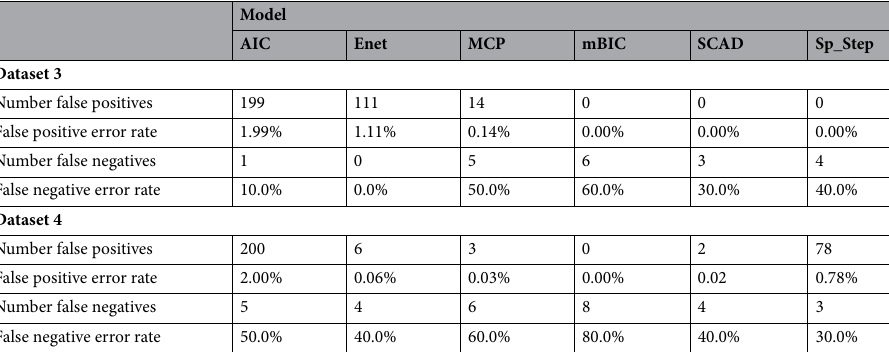
Table 3. Error rates in variable selection of six statistical methods conducted on two simulated datasets. Datasets 3 and 4 both contained 200 observations and 10,010 potential explanatory covariates of which 10 were simulated to be ‘correct’ covariates and calculated to have a true effect on the outcome. The true covariates in Dataset 3 explained 73% of the variability in outcome and those in Dataset 4 explained 63%. AIC Stepwise selection based on Akaike Information Criterion, Enet elastic net regression, MCP minimax convex penalty, mBIC modified Bayesian Information Criterion, SCAD smoothly clipped absolute deviation, Sp_Step SparseStep